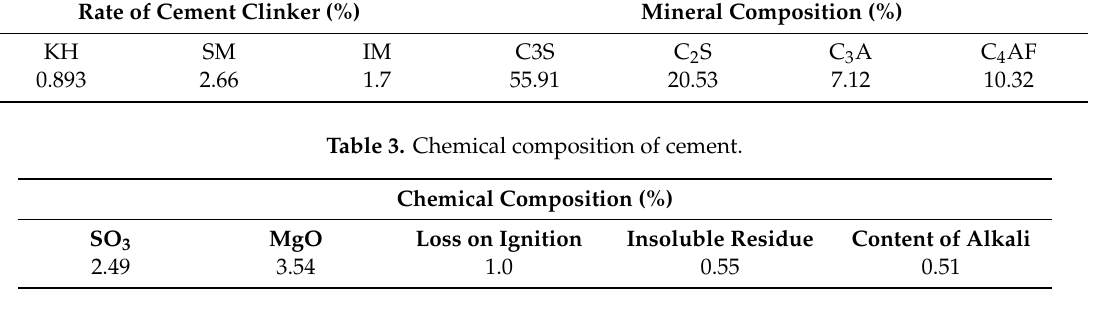
Table 4. Physical properties of